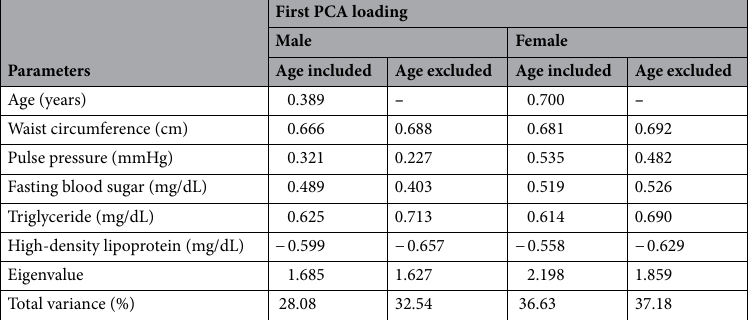
Table 3. First principle components of the parameters for metabolic syndrome. Pulse pressure = systolic blood pressure – diastolic blood pressure. All parameters are P < 0.001. PCA principal component analysis.